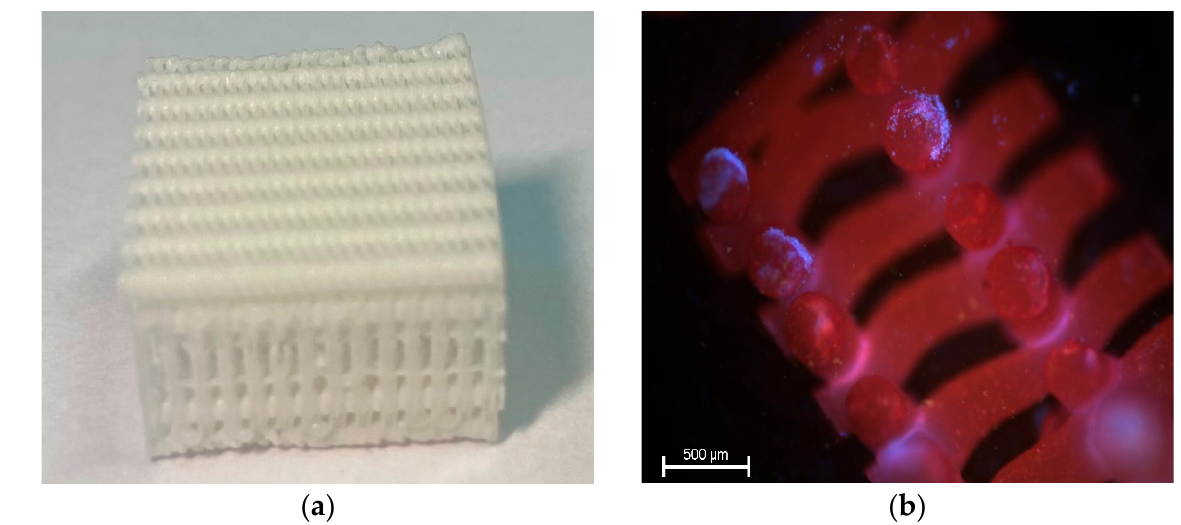
Figure 1. Photograph of the 3D printed composite scaffold used in the present study ( a ). Fragment of the scaffold settled with BM-MSCs (shown in blue) stained with DAPI. Magnification ×40 ( b ).